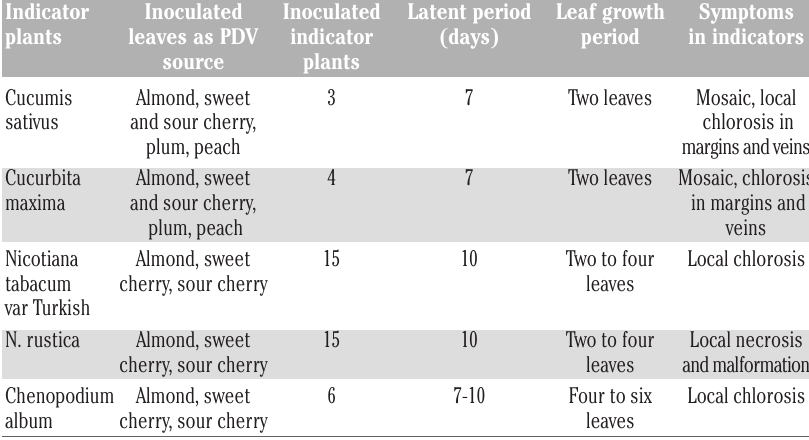
Table 3. Mechanical transmission of PDV and its respective results.